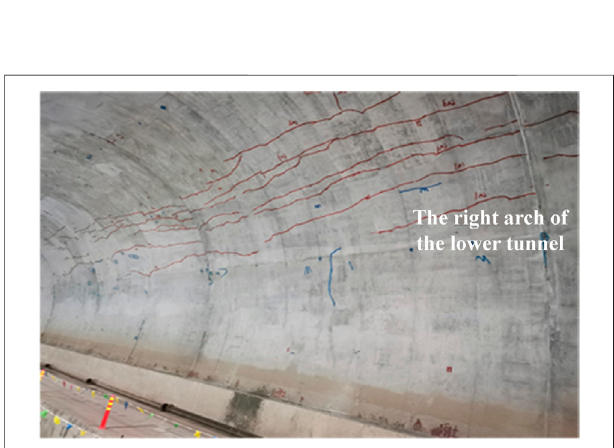
FIGURE 12 | Site photo of the partial longitudinal crack on the right side of the lower tunnel.